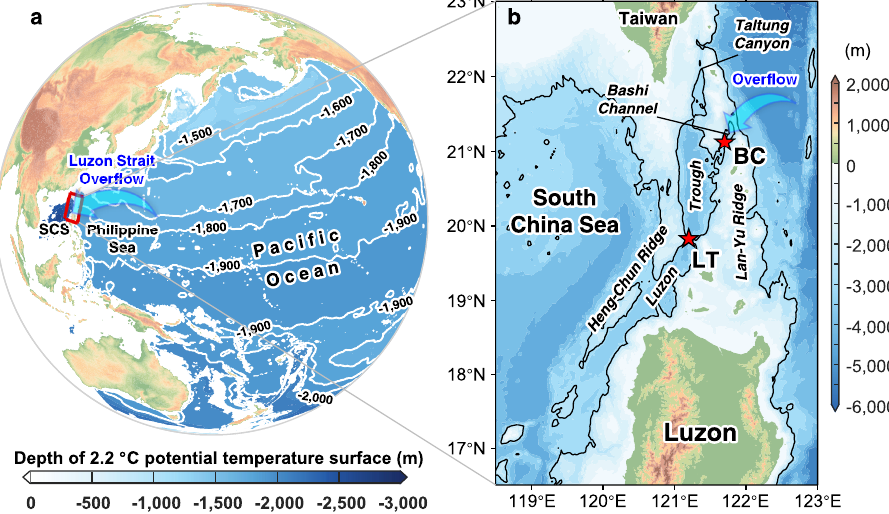
Fig. 1 | Location of the Luzon Strait. a Depth of 2.2°C potential temperature surface in the Paci fi c, using updated data from the World Ocean Atlas 2013. b Enlargedmapoftheredboxin( a )withtopographyfromSRTM15+ 69 bathymetry. Red stars mark the mooring positions in this study. The black solid line represents